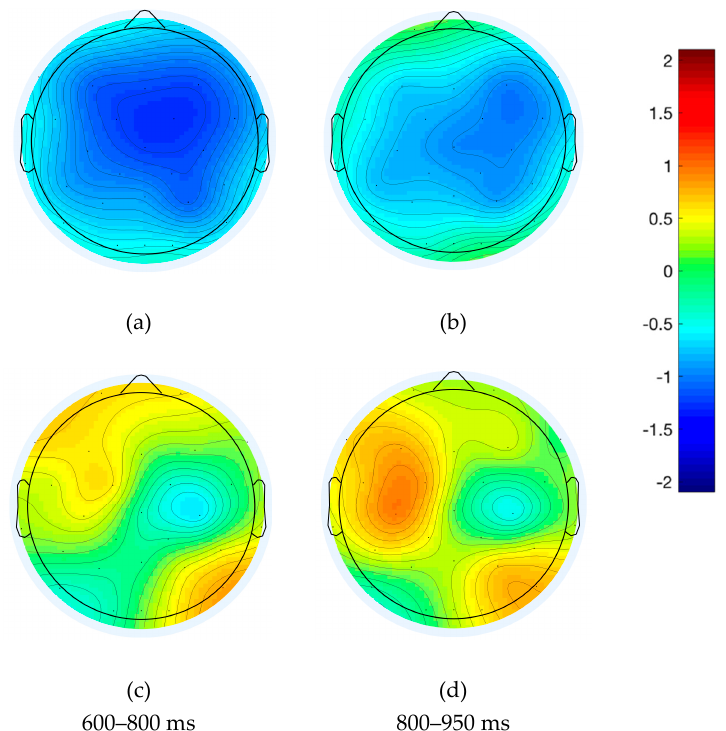
Figure 7. Scalp topographies of the difference waves in non-native speakers, showing the effects of ( a – b ) Distractor Plausibility (Plausible–Implausible) and ( c – d ) Order (TD–DT in plausible trials) in the 600–800 ms and 800–950 ms time windows, respectively.